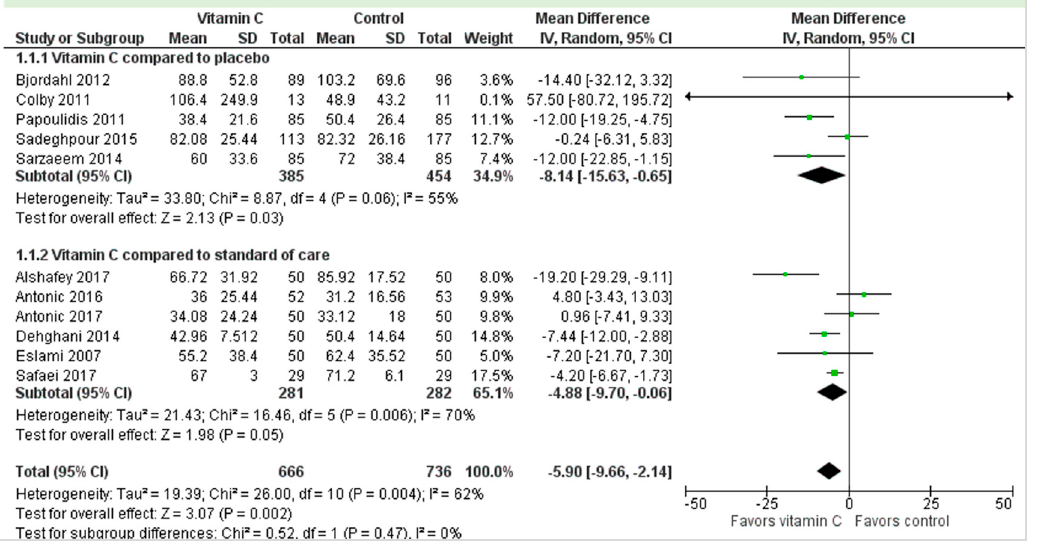
Figure 20. ICU length-of-stay: subgroup analysis—influence of control group.